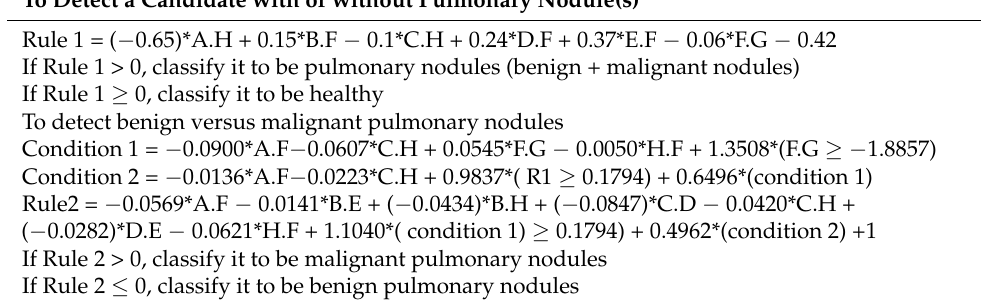
Table 4. Performance of pfeRNAs for detecting healthy controls, patient controls with benign, and